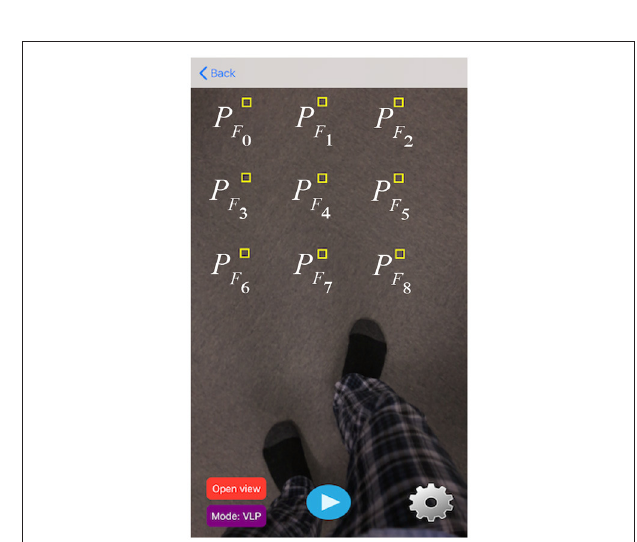
s displayed on the i